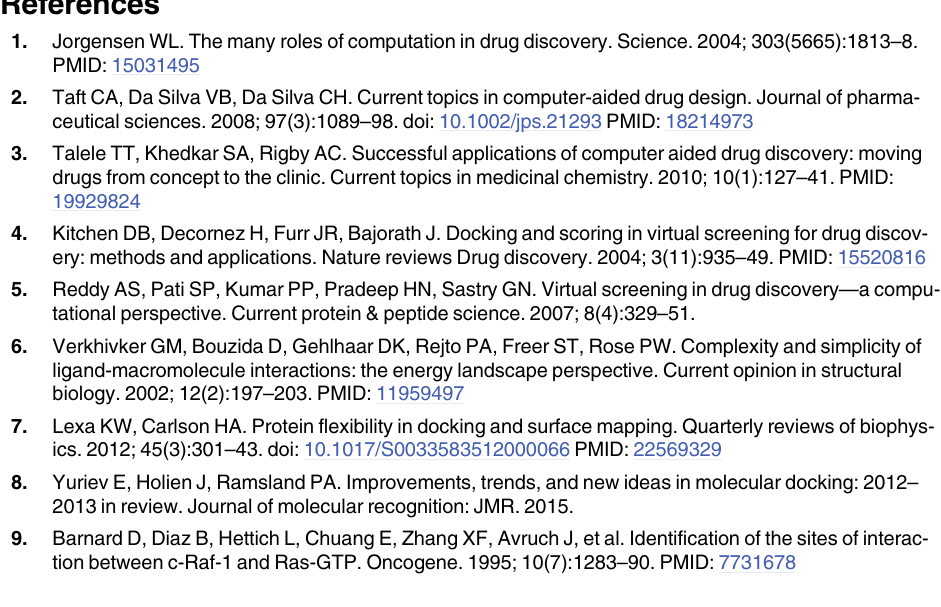
S2 Table. Astex Diverse Set and CDK2 datasets. S3 Table. SEQ17 dataset. S4 Table. SEQ17 cross-docking results. S5 Table. CDK2 cross-docking results. S6 Table. CDK2 docking success rates for AutoDock Vina with higher exhaustiveness. S7 Table. AutoDock Vina execution time scaling for varying exhaustiveness and levels of